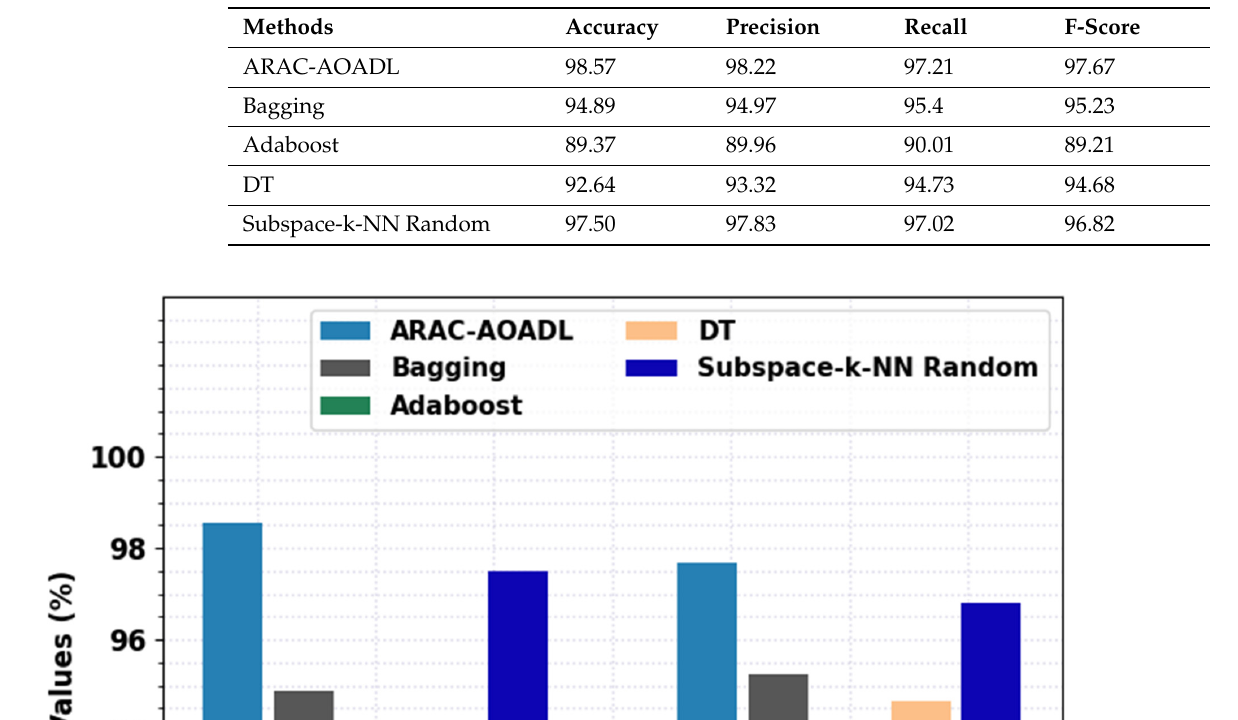
Table 4. Comparative RA Classification results of ARAC-AOADL model.